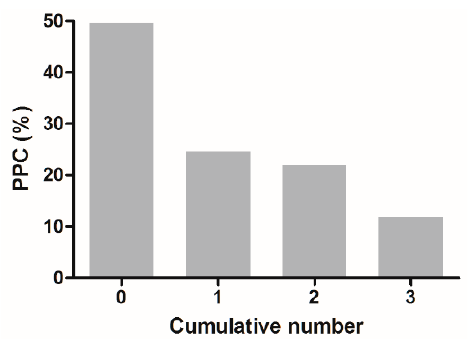
Figure 4. The incidence of postoperative pulmonary complications (PPCs) according to the number of cumulative protective anesthetic interventions.